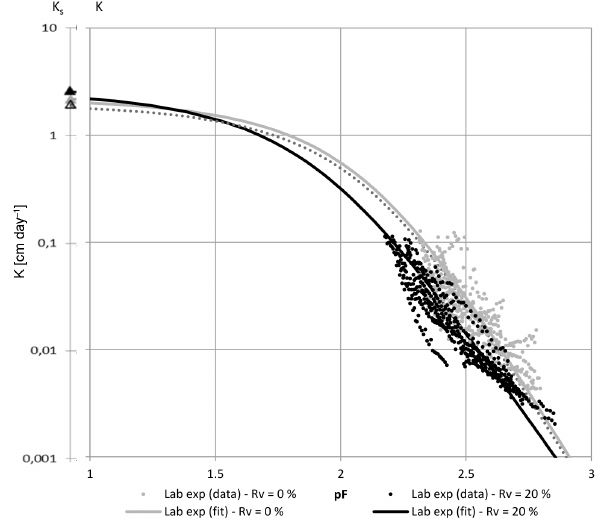
Figure 6. Hydraulic conductivity curves obtained from laboratory experiments (data and fit for R v = 0 and 20%) and results predicted by the models for a R v of 20% (dotted line). Triangles are satu- rated hydraulic conductivity: closed is measured with black for the stony and grey for the fine earth, and open is predicted by the model (median value of the